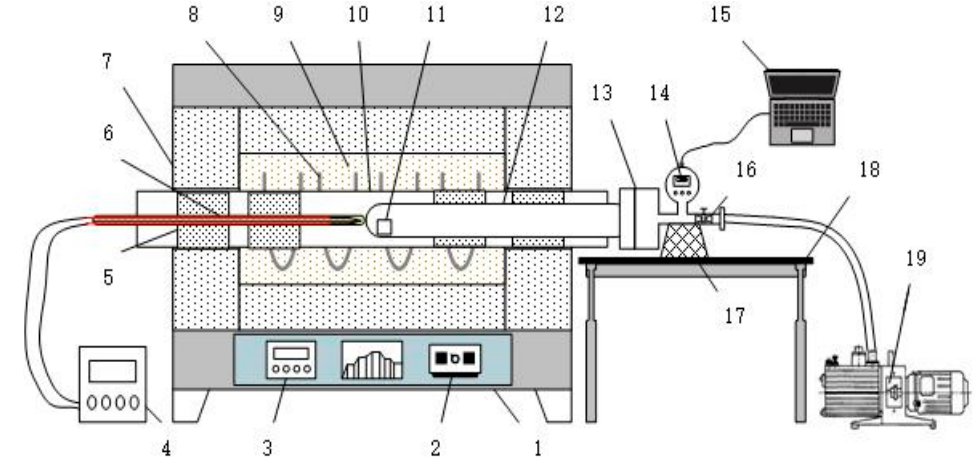
Figure 1. The schematic illustration of a vacuum tube furnace.